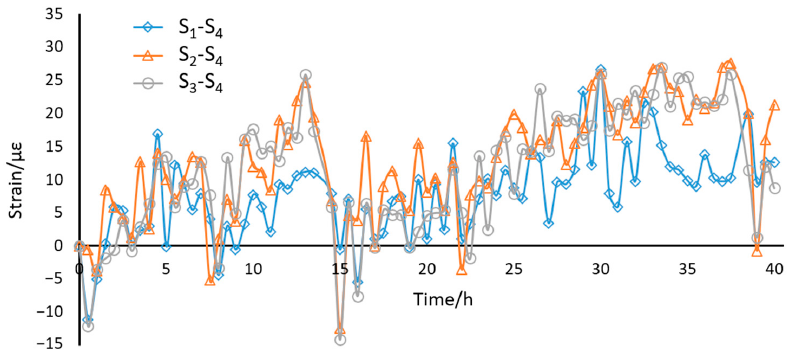
Figure 6. The results after being compensated by S 4 .